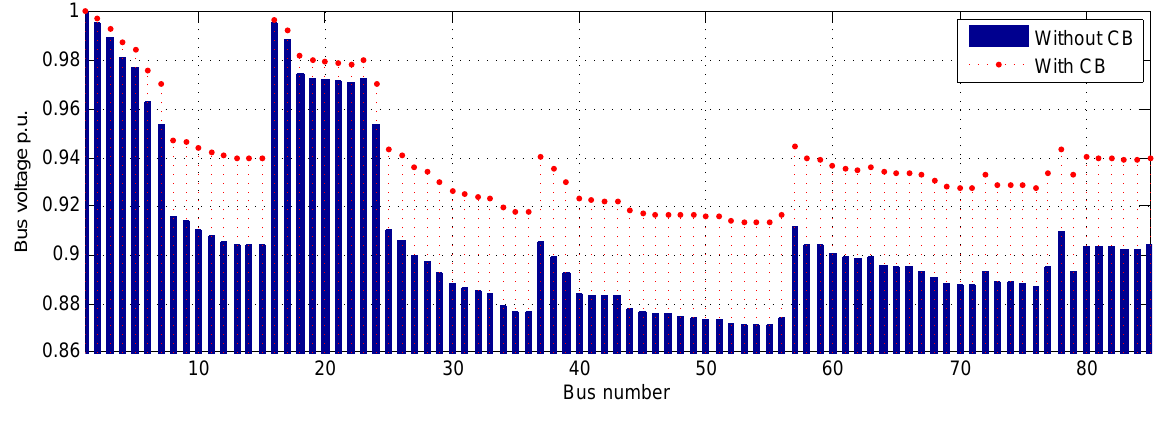
Figure 10. Voltage profile: 85-bus system. Table 8. Convergence characteristics for the 10-, 34-, and 85-bus